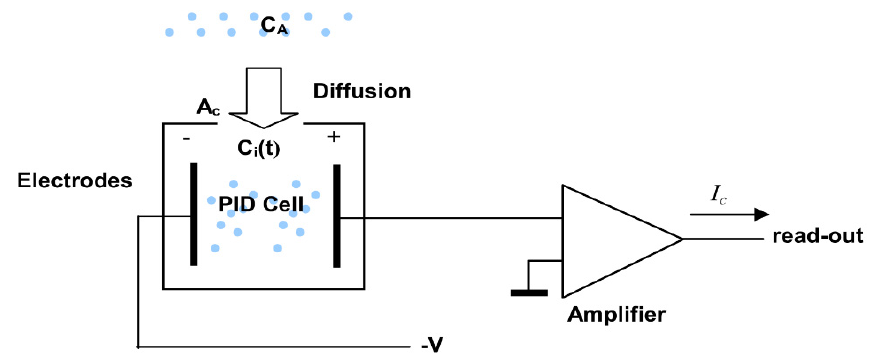
Figure 4. Ionization and diffusion process under steady-state conditions.